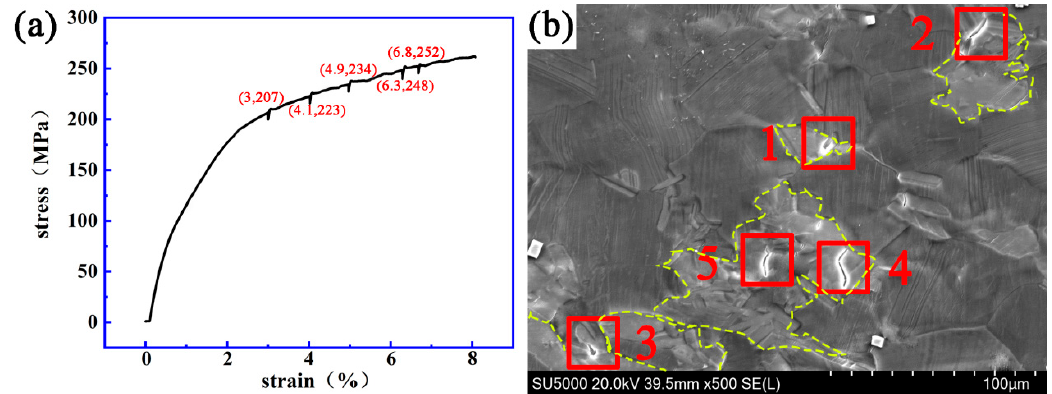
Figure 7. The dynamic change process of crack initiating and extending a Mg-13Gd-5Y-3Zn-0.3Zr alloy after solution treatment at 510 °C for 10 h. ( a ) The stress–strain curve. ( b ) The evolution process of the micro-crack.